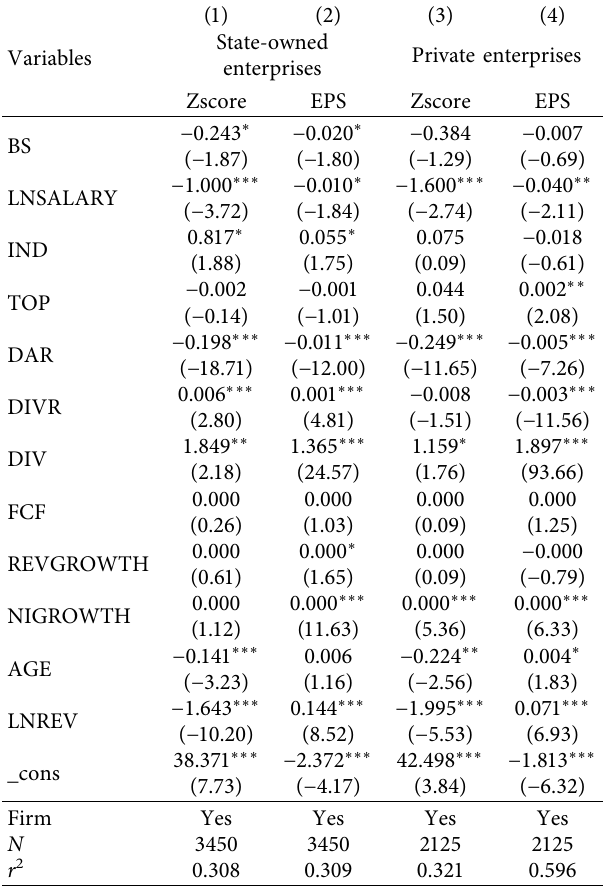
Table 4: Panel OLS regression of the effect of corporate governance on corporate sustainable development.